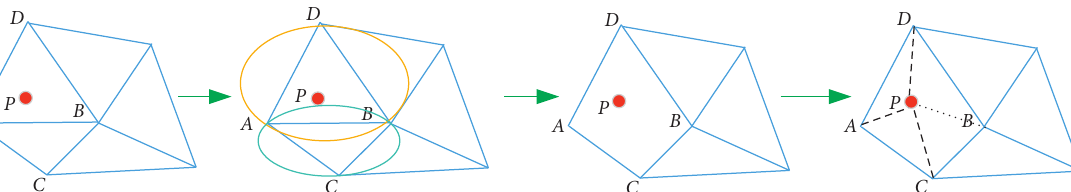
Figure 3: Triangular mesh reconstruction algorithm.